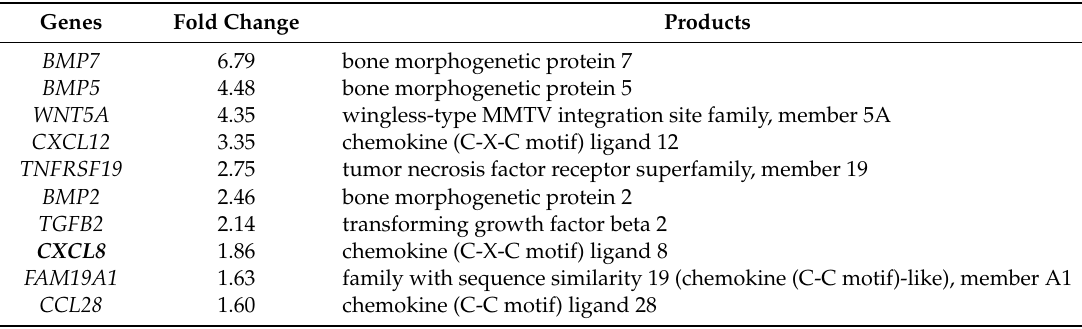
Table 3. Upregulated cytokine genes in human synovial sarcoma